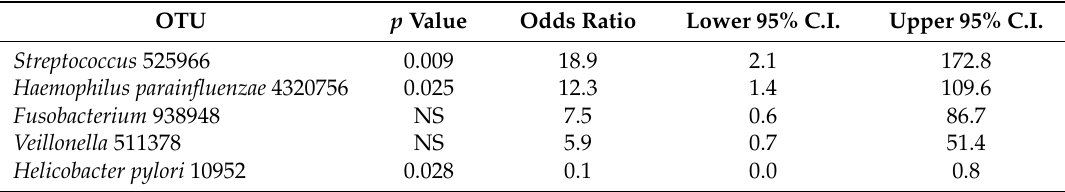
0.27 0.003 Prevotella pallens 705241 0.68 0.49 0.88 - NS Haemophilus 0.71 0.54 0.89 6.5 0.73 0.27 0.025 parainfluenzae 4320756 Helicobacter pylori 10952 0.75 0.65 0.008 NS: p value is not statistically significant ( p > 0.05). Table 2. Age adjusted multivariate logistic regression analysis of microbial biomarkers for H. pylori - negative gastritis. OTU p Value Odds Ratio Lower 95% C.I. Upper 95% C.I. Streptococcus 525966 0.009 18.9 2.1 172.8 Haemophilus parainfluenzae 4320756 0.025 12.3 1.4 109.6 NS NS 51.4 Helicobacter pylori 10952 0.028 0.1 0.0